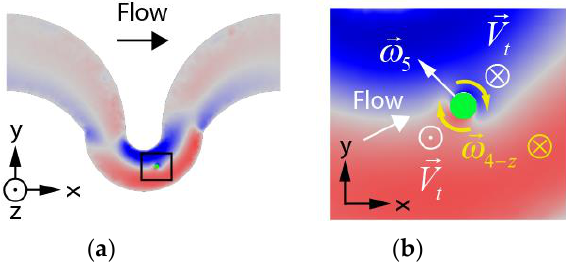
Figure 13. ( a ) z -component of the transverse flow field. Reddish regions correspond to flow moving upwards and vice versa for bluish regions; ( b )The vertical rotational component of the particle (ω 4−z ) induces a disturbance in this component of the lateral flow field (yellow arrows) that modifies the behavior of the rotating particle (ω 5 component).